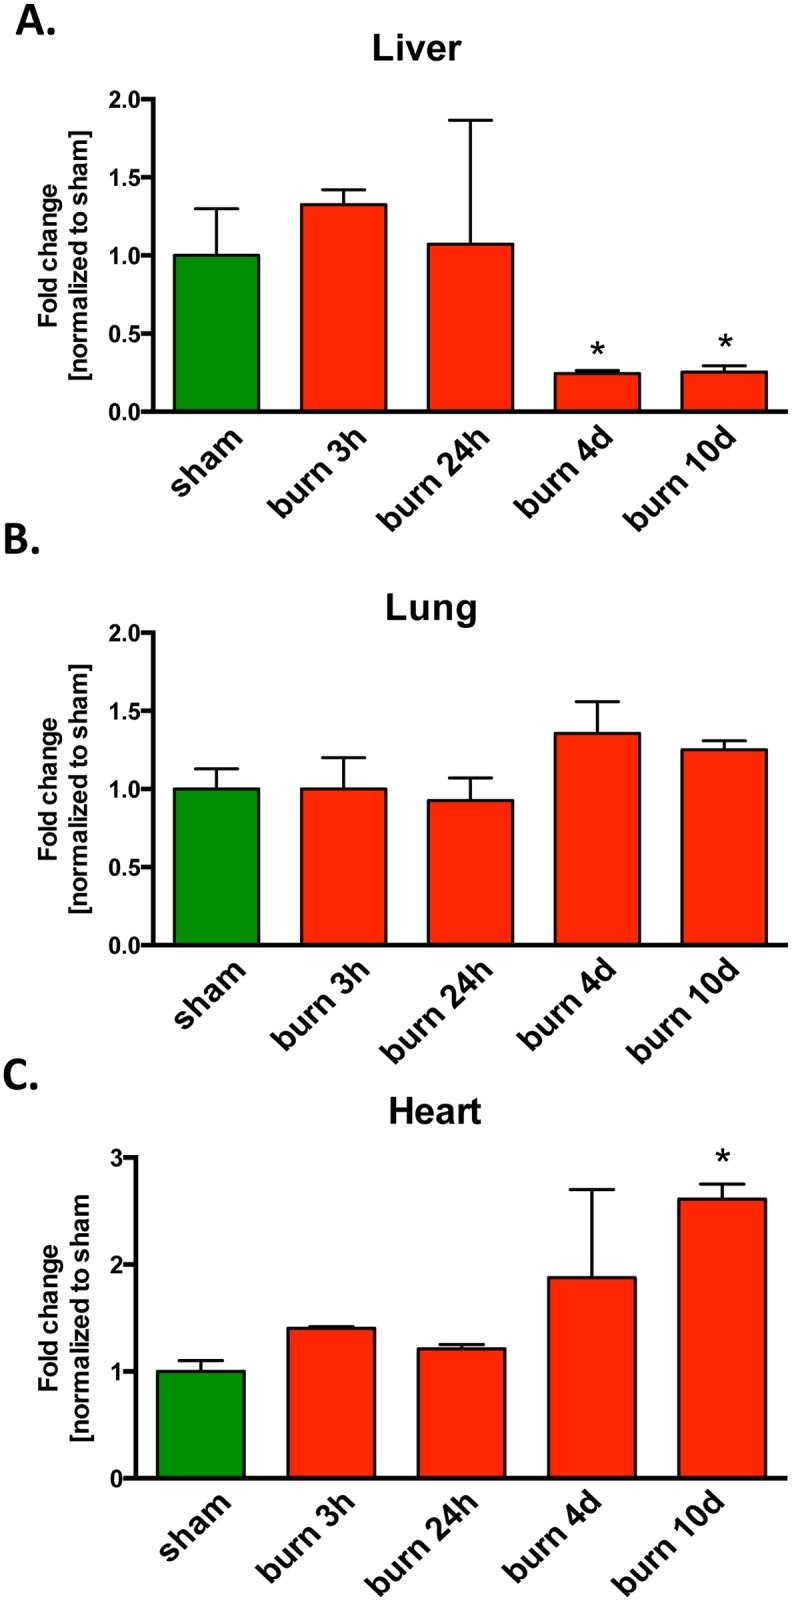
Changes in the amount of poly(ADP-ribose) (PAR) groups in response to burn injury.PARylation in total cell extracts was analyzed in (A) liver, (B) lungs and (C) heart of mice subjected to burn injury and compared to sham treated animals. The results are based on n = 4 per group and represent mean±SD. *p<0.05, relatively to sham treated animals.